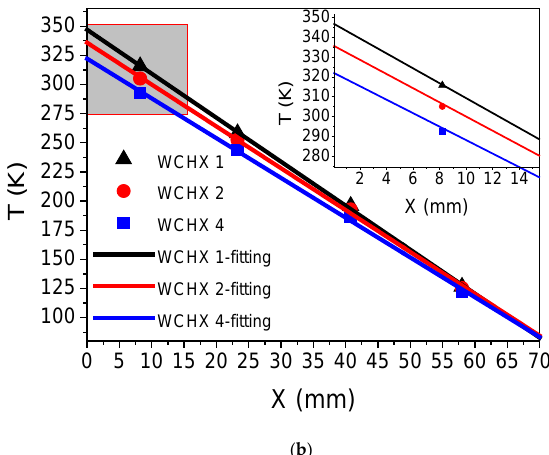
Figure 6. Temperature distribution in the regenerator at input acoustic power of ( a ) 1270 W and ( b ) 5000 W for WCHXs 1, 2, and 4.